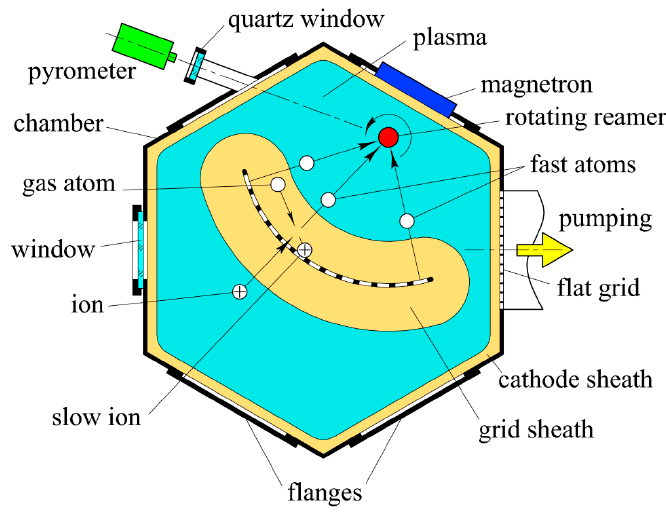
Figure 3. Schematic diagram of the experimental setup.